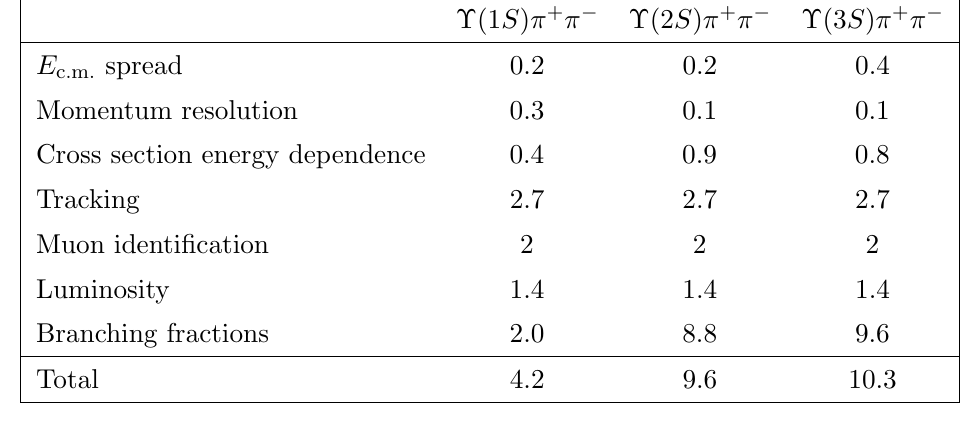
Table 2 . The systematic uncertainties in the e + e (cid:0) ! (cid:7)( nS ) (cid:25) + (cid:25) (cid:0) ( n = 1 ; 2 ; 3) cross sections correlated among various energy points (in